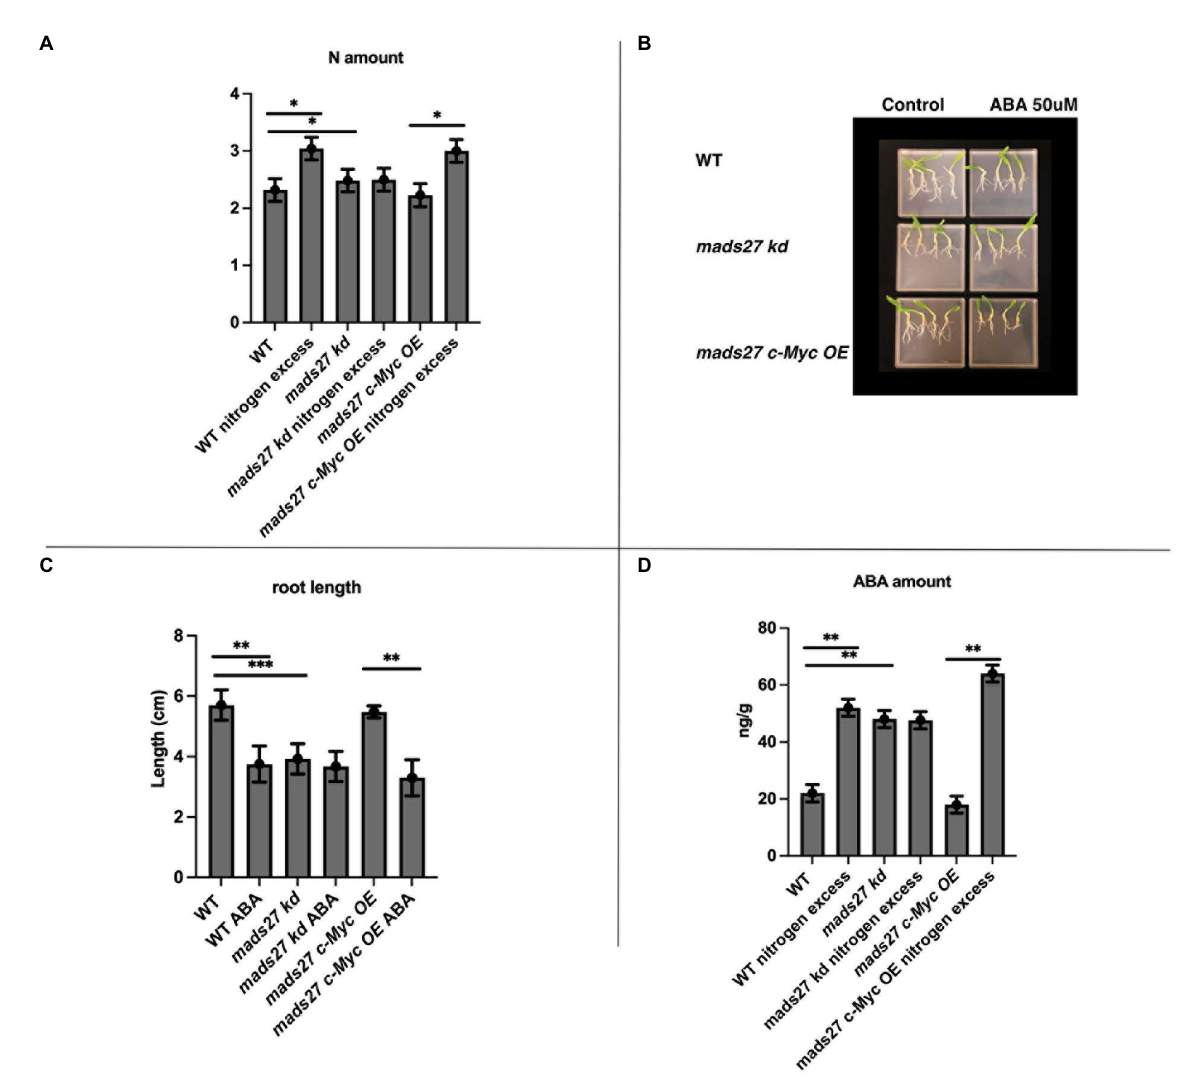
FIGURE 4 HvMADS27 controls N excess-dependent abscisic acid (ABA) accumulation in barley roots. (A) Determination of N content of the roots of WT , mads27 kd , and mads27 c-Myc OE plants using elemental analyzer. (B) ABA-sensitivity assay of the roots of WT and transgenic plants grown on ½ MS plates under control conditions or with 50 μ M ABA supplementation. (C) Calculation of root length, with x -axis representing the variants and y -axis representing root length in cm. Roots of mads27 kd plants were shorter than those of plants from the other lines under control conditions and did not respond to ABA supplementation, whereas the roots of mads27 c-Myc OE mutants responded to ABA in WT-like manner. (D) ABA concentration of the roots was determined using ultra-high-pressure liquid chromatography, with the x -axis representing the variants and the y -axis representing ABA concentration in ng/g. There was an accumulation in ABA and N concentration in the roots of WT and mads27 c-Myc OE plants under excess N stress, whereas the accumulation of N and ABA in the roots of mads27 kd mutants was high both under control and excess N stress conditions. Mean comparison was performed using Student’s t -test; * p < 0.05, ** p < 0.01, *** p <